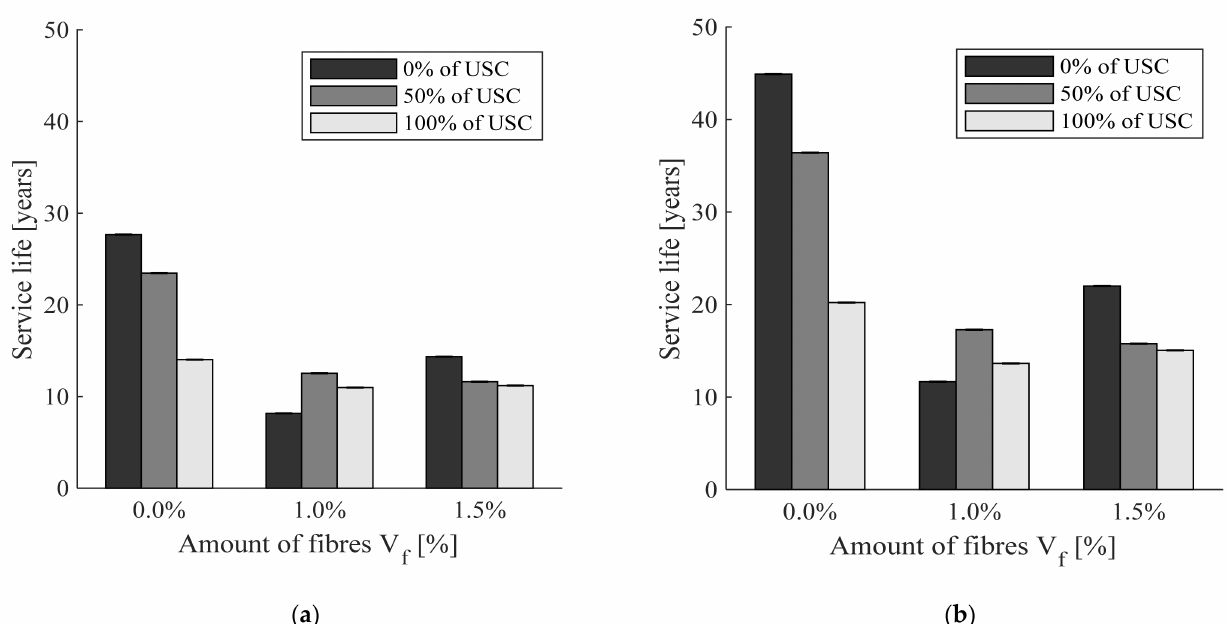
Figure 6. The service life regarding ( a ) the constant diffusion coefficient and ( b ) the time-dependent diffusion